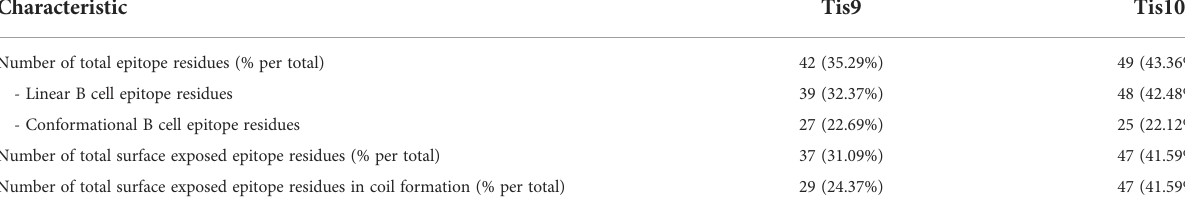
TABLE 4 Protein conformation and B cell epitope characteristics of Tis9 and Tis10